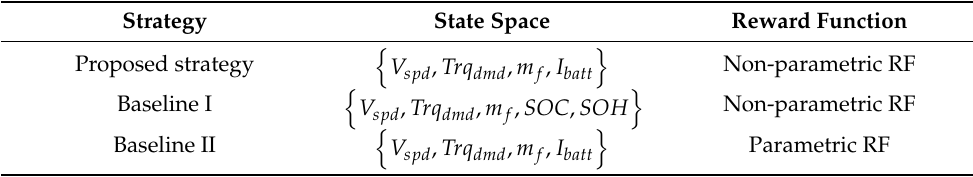
Table 3. Comparative Features of Different Strategies.